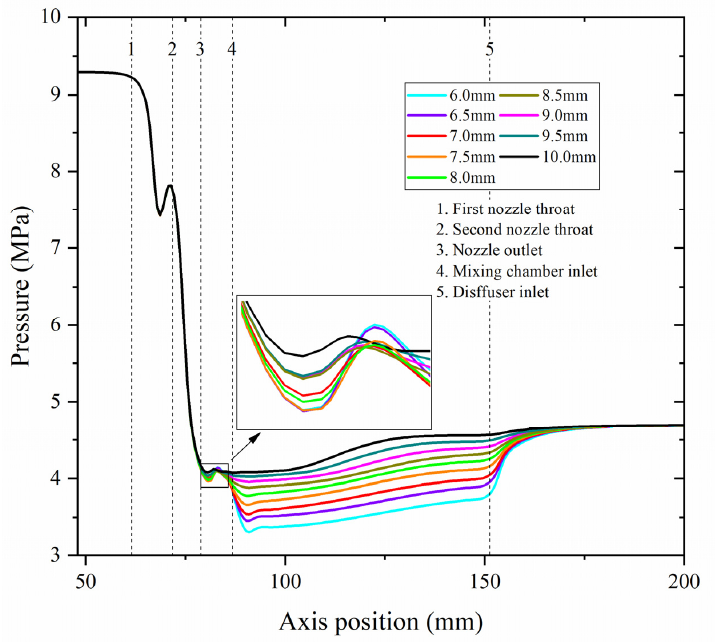
Figure 8. Variations of axial static pressures under different D m ( P p of 9.3 MPa).